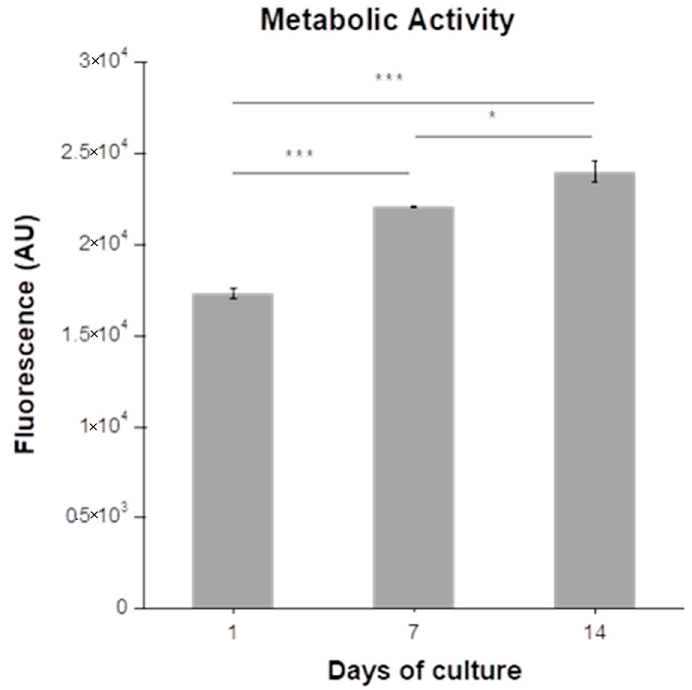
Figure 8. Metabolic activity of chondrocytes encapsulated in MeHA hydrogels (7.5 w / v%). The data were analyzed using one-way analysis of variance (ANOVA) with Tukey’s post hoc test and are presented as mean values ± standard error of the mean (plugs = 6), * p < 0.05, ** p < 0.01, *** p < 0.001 .